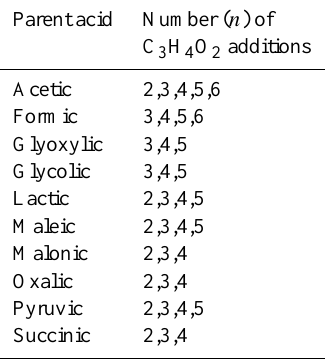
Fig. 2. Kendrick mass plot of neutral unique molecular formulas normalized to CH 2 for continental and coastal storms presorted at z ∗ = − 10. Horizontal lines with the same Kendrick mass defect rep- resent molecular formula families that increase by one methylene unit.